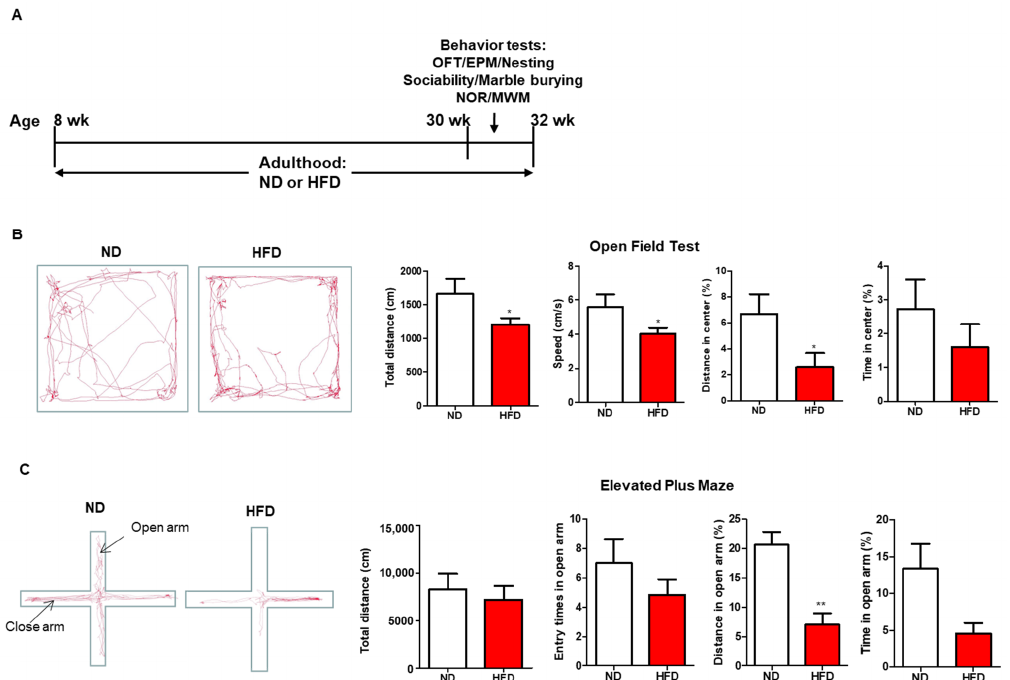
Figure 2. Effect of long-term HFD consumption on anxiety- and depression-like behavior in mice. Experimental design ( A ). Representative movement trace images, total distance, speed, percentage of distance in center, and time in center in Open Field Test of ND- and HFD-fed mice ( B ). Representative movement trace images, total distance, entry times in open arm, percentage of distance in open arm, and time in open arm of Elevated Plus Maze test ( C ). ND, normal diet; HFD, high-fed diet. Values are shown as the mean ± SEM. t -test was performed. * p < 0.05; ** p < 0.01.